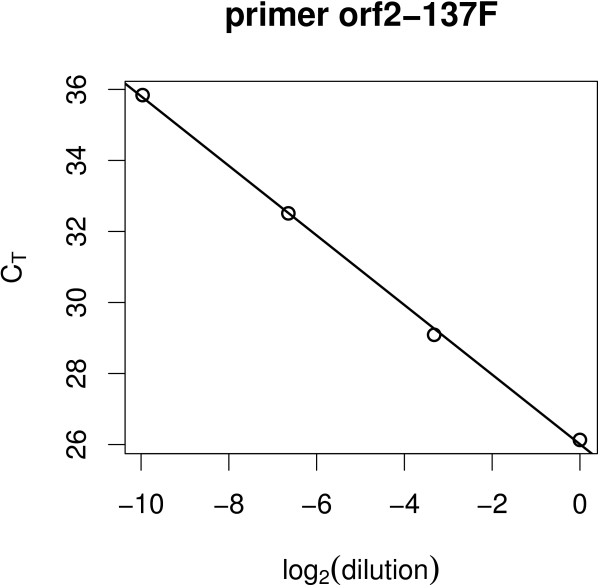
Shown is an example of the experimental data that serve as input for further calculation. The logarithm (log2) of the initial concentration is shown on the horizontal axis and the CT values on the vertical axis. CT values are measured at initial dilution levels 1, 0.1, 0.01 and 0.001 and exhibit a strong linear trend.